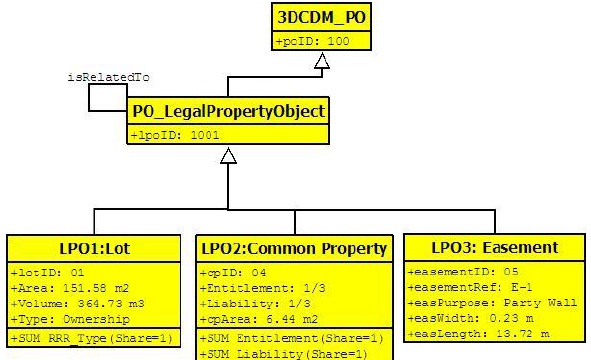
Figure 17. Instance of PO_LegalPropertyObject association of